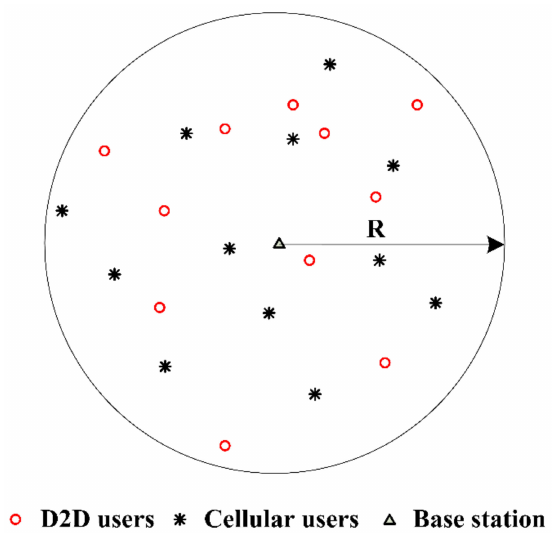
Figure 3. Illustration of a communication area where users are normally distributed around the base